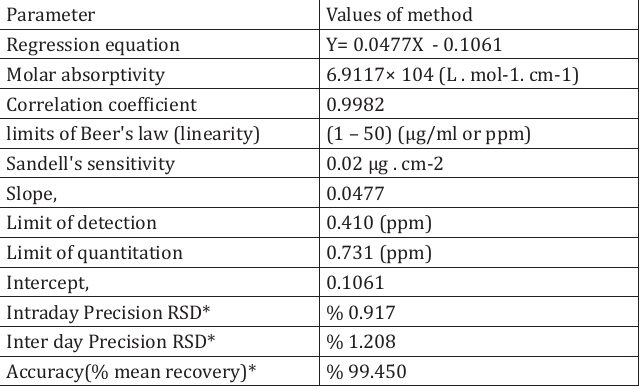
Experimental limitation qualities from the consistent method of the calibration curve